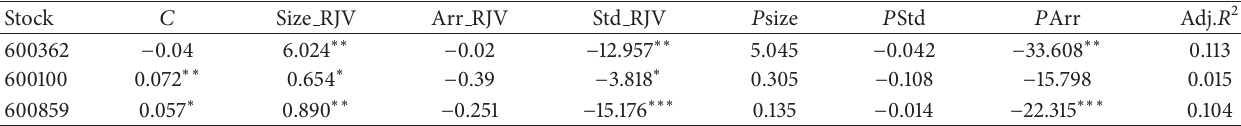
Table 6: Forecasting one-month-ahead individual stock portfolio returns using realized jump volatility-based factor model with market-level jump components.